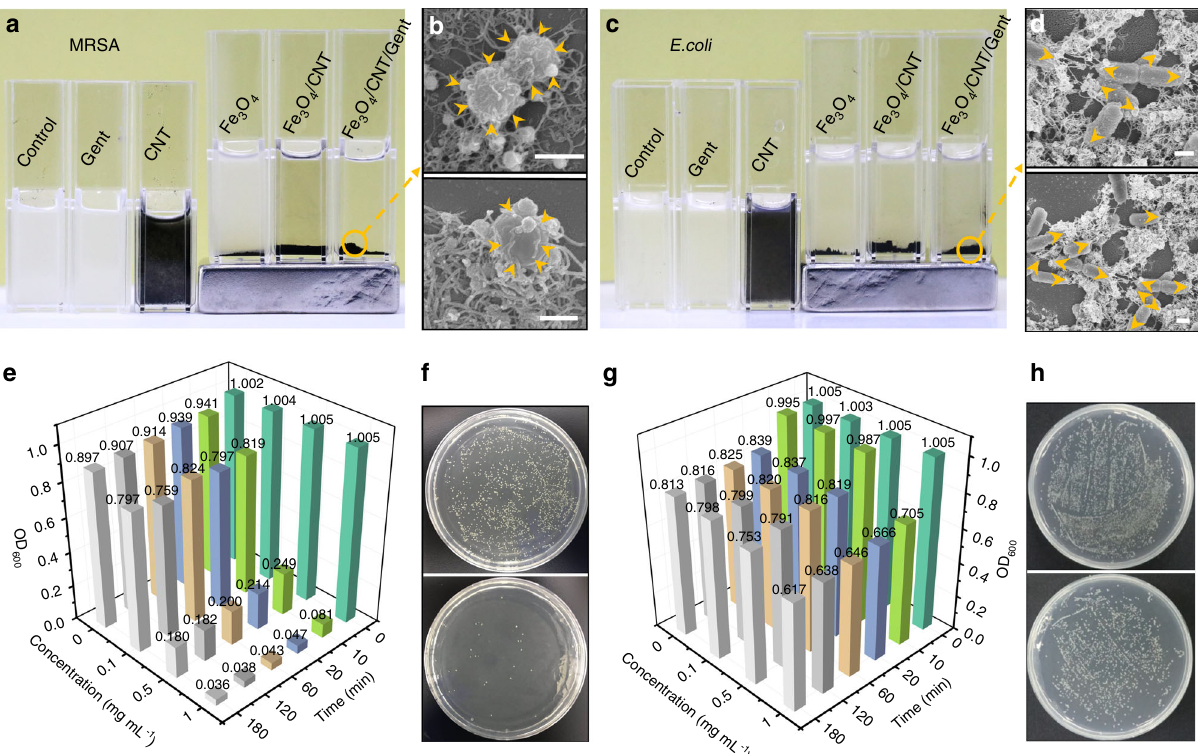
Fig. 4 The bacteria-capturing ability of Fe 3 O 4 /CNT/Gent nanocapturer. a – d Capturing MRSA ( a ) and E. coli ( c ) by different samples. Neodymium rare earth permanent magnet with grade N38 magnetic energy. Representative SEM observation of Fe 3 O 4 /CNT/Gent binding to MRSA ( b ) and E. coli ( d ). The orange arrows in b , d indicate the Fe 3 O 4 /CNT/Gent attached to bacteria. Scale bar, 500 nm. e – h The overall capturing bacteria viability as a function of time and Fe 3 O 4 /CNT/Gent concentration for MRSA ( e ) and E. coli ( g ). OD value is positive correlated with the amounts of bacteria in the solution. The spread plate of MRSA ( f ) and E. coli ( h ) before (above) and after (below) dispersing Fe 3 O 4 /CNT/Gent. n = 1 independent sample for e , g . Source data are provided as a Source Data fi